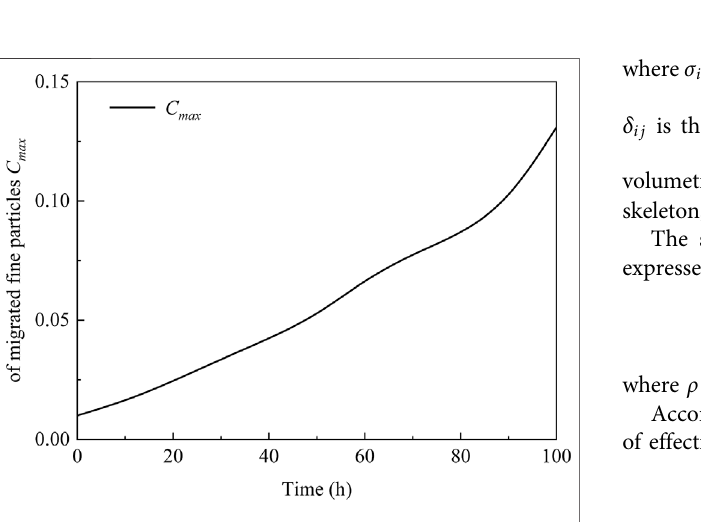
FIGURE 7 | Spatial distribution of the migrated fi ne particles volume fraction in the embankment dam slope. (A) t = 0, (B) t = 50 h, and (C) t = 100 h.